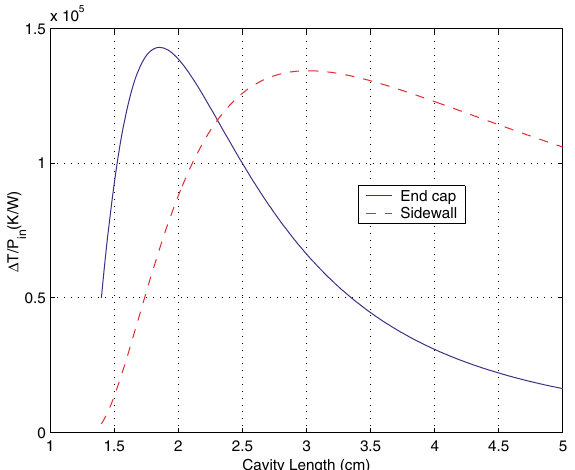
FIG. 3. (Color) Maximum temperature rises on cavity end caps and sidewall normalized to input power as a function of cavity length d at a fixed resonant frequency of 11.424 GHz. This plot does not include consideration of temperature rise at the coupling